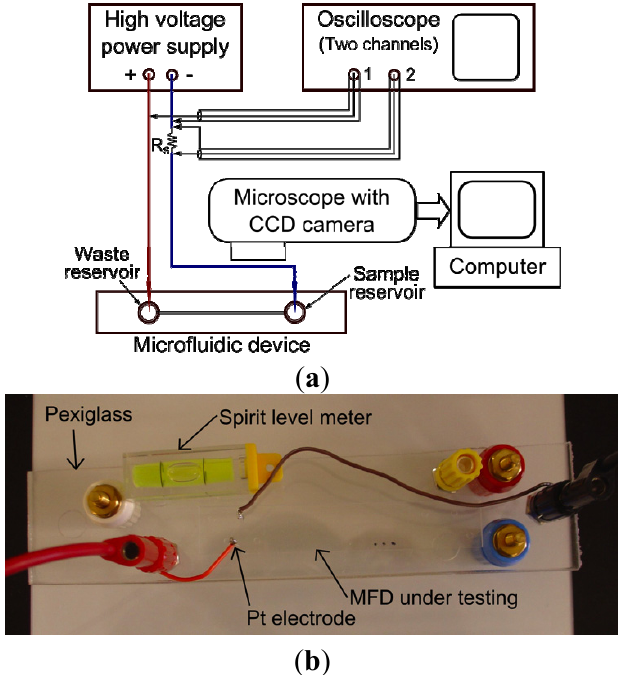
Figure 2. ( a ) A schematic diagram of the experimental setup of the microfluidic device; ( b ) a photograph of the experimental setup showing the Pexiglass platform, microfluidic device (MFD), spirit level meter and the electrical connections of the platinum (Pt) electrodes inside the access holes.